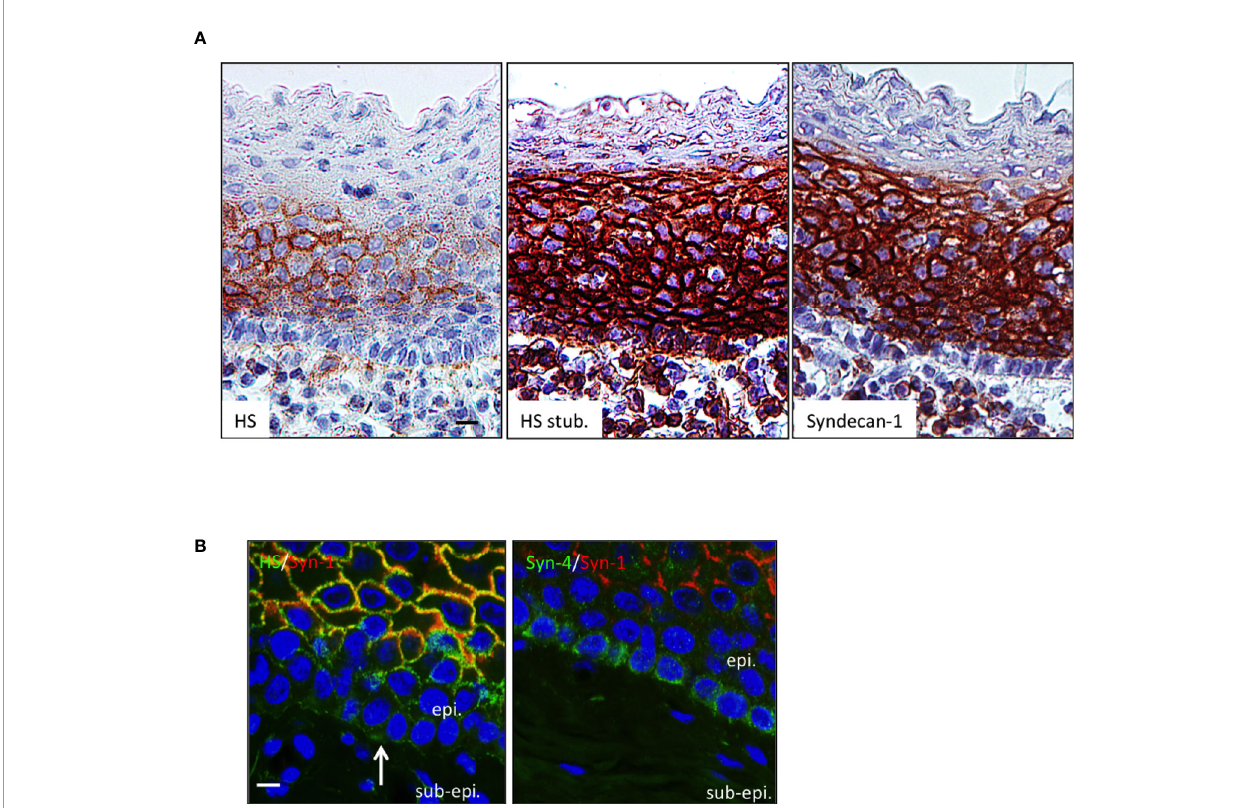
FIGURE 2 | The HSPG syndecan-1 and -4 are expressed by tonsil epithelial cells. (A) Serial sections of tonsils were stained for native HS chain (10e4 reactivity), the HS stub (3g10 reactivity), and syndecan-1. Scale bar = 10 µm. (B) Tonsil sections were costained for 10e4 (green)/syndecan-1 (red) and syndecan-4 (green)/ syndecan-1 (red). Scale bar = 5 µm. The surface epithelium is shown. In some fi gures, the epithelium (epi.) and sub-epithelium (sub-epi.) are marked. The arrow and box show the basement membrane and a plasmocyte, respectively. Results are representative of more than 15 tonsillectomies for patients with recurrent